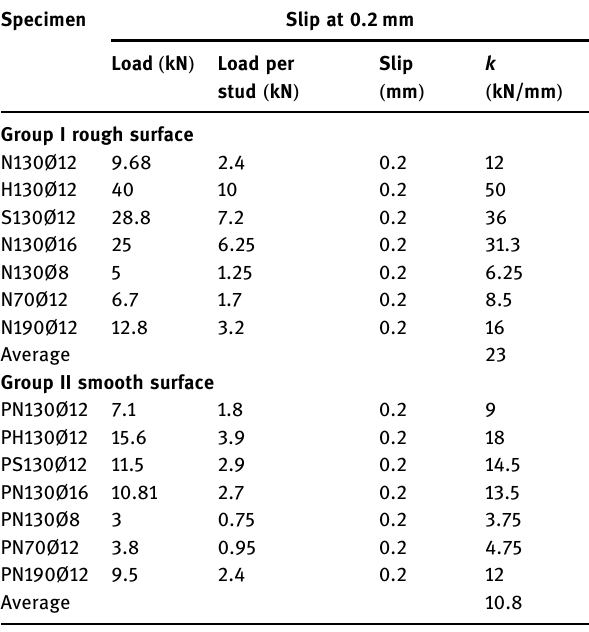
Table 7: Summary of shear sti ff ness of pushout specimens Specimen